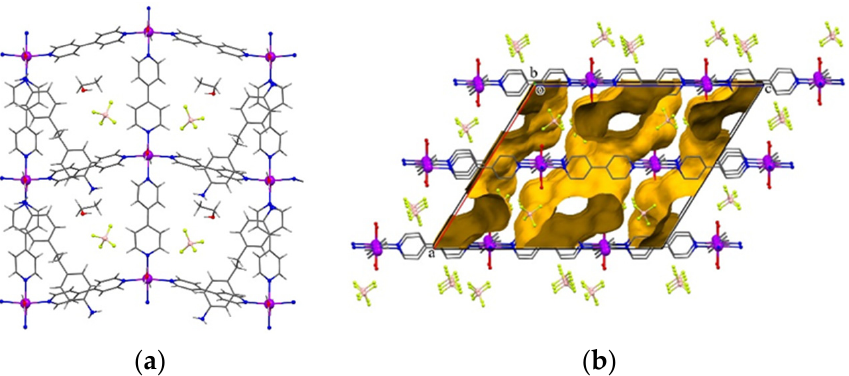
Figure 6. Compound 6 . ( a ) Fragment of cationic 2D grid with outer-sphere tetrafluoroborate anions and dadpe and EtOH guest molecules. ( b ) Crystal packing with voids shown in yellow.